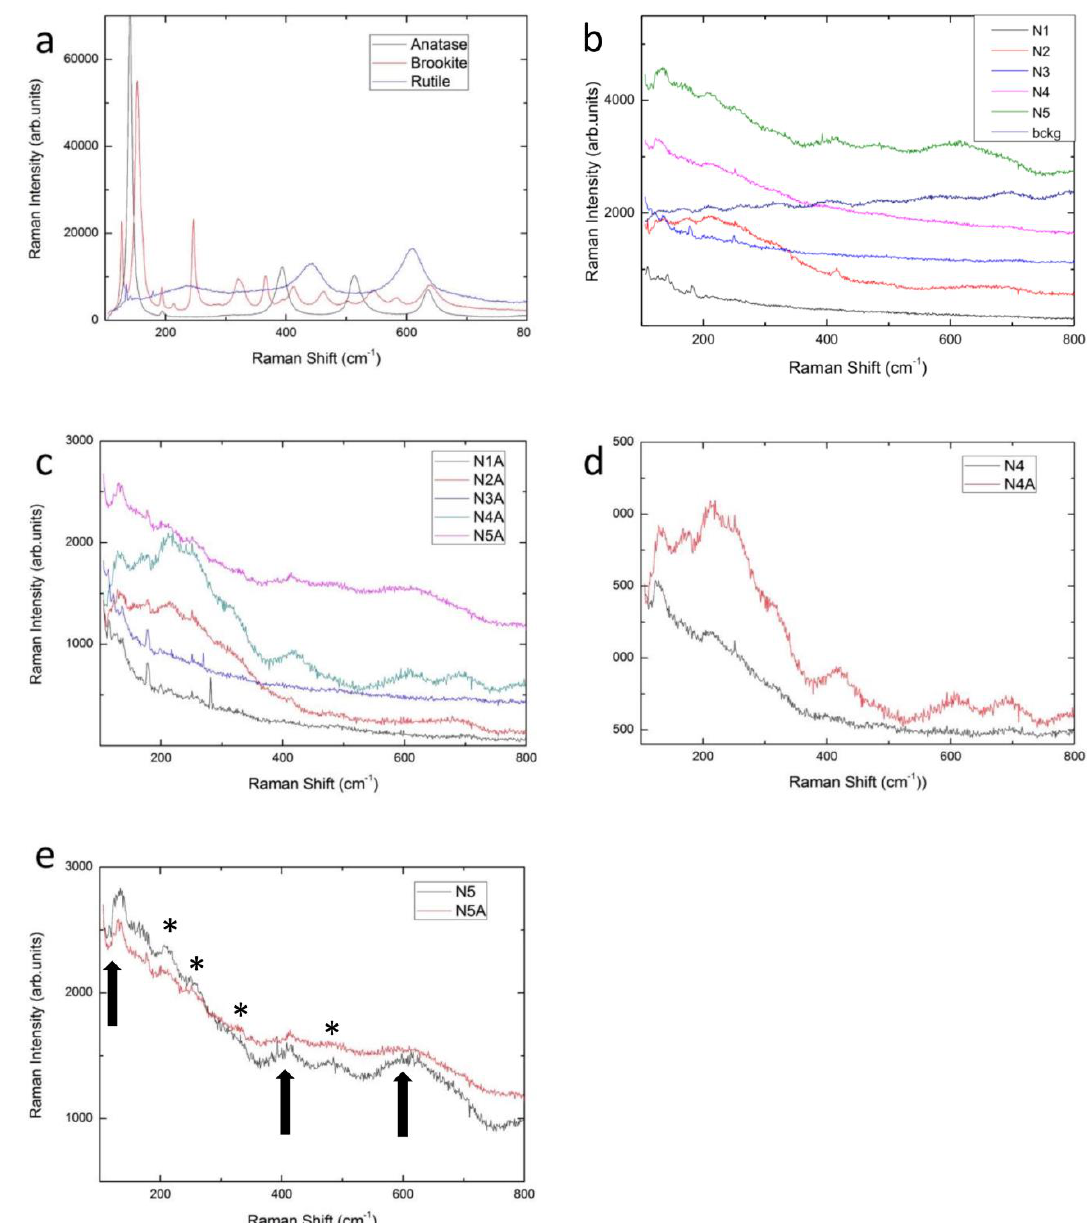
Figure 1. Raman spectra at room temperature for different systems: ( a ) anatase, rutile and brookite synthetic powders; ( b ) samples N1-N5 and the background signal for N5 sample; ( c ) CP-treated samples N1A-N5A. In panels ( d ) and ( e ) a comparison between untreated and CP-treated samples is reported respectively for N4 and N5 samples. The arrows in Figure 1e indicate the TiO2 Raman bands while the asterisks indicate the main ripple structures.